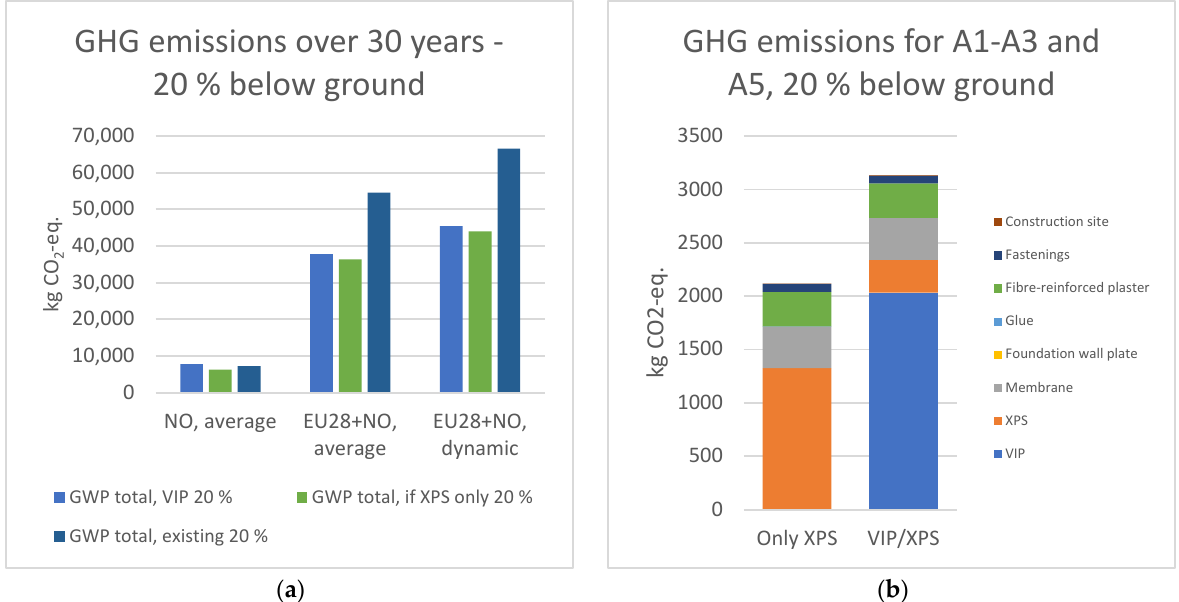
Figure 6. ( a ) Accumulated GHG emissions over 30 years for three different electricity scenarios, with 20% of the wall below the ground; ( b ) GHG emissions for materials and construction (life cycle modules A1–3 and A5), with 20% of the wall below the ground.